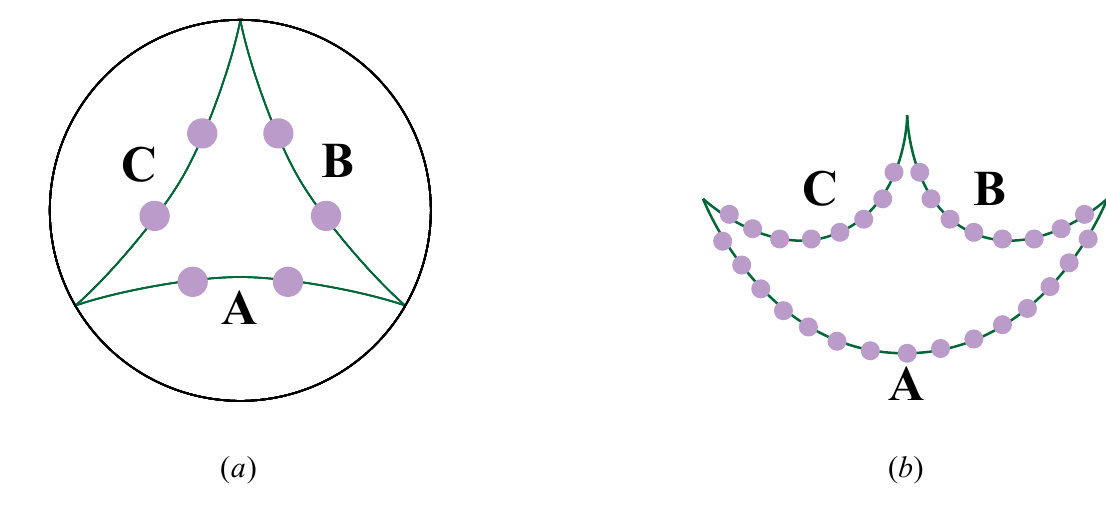
Figure 4 . SS bit model: (a) A simple model consisting of three congruent RT surfaces (represented by green lines). Each surface has only two “SS bits “ (represented by mauve discs), and each SS bit has only two states, | 1 i and | 0 i . (b) A more general case involving S A , S B , S C SS